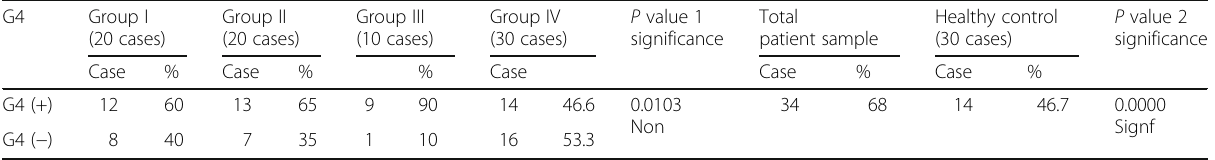
Table 7 Frequency distribution for presence and absence of G4 allele